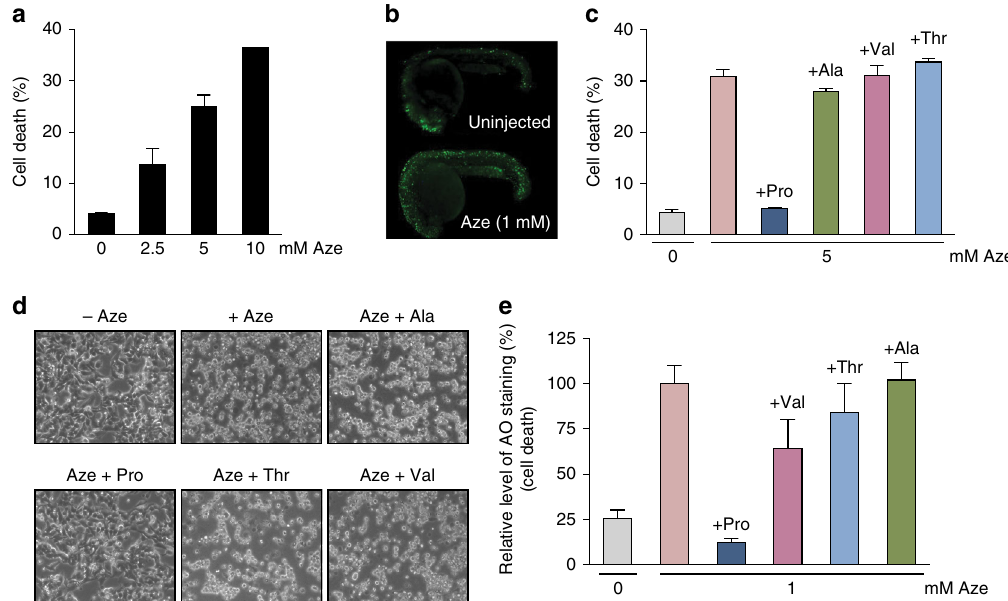
Fig. 2 Pro rescues Aze toxicity in mammalian cells and zebra fi sh. a Cell death measured after 24 h of Aze treatment on HeLa cells. b Acridine orange (AO) staining of 24 h.p.f. zebra fi sh uninjected or injected with 1 mM Aze visualized under a fl uorsecent microscope. c HeLa cells were treated with 5 mM Aze with either no amino acid, 1 mM Ala, Pro, Val, or Thr. Cell death was quanti fi ed and plotted. d Image of cells for c . e Quanti fi cation of AO staining of 24 h.p.f zebra fi sh uninjected, or injected with 1 mM Aze, or 1 mM Aze with either 0.25 mM Pro, Val, Thr, or Ala. (Error bars represent s.d. ( a , c ) or s.e.m. ( e ))